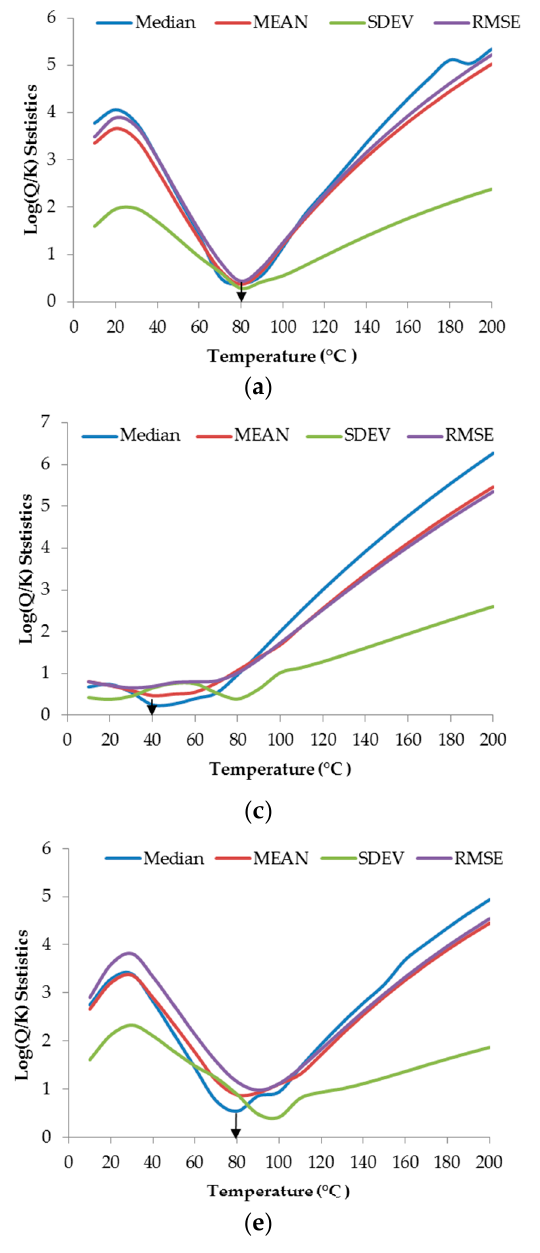
Figure 11. Statistical analyses of saturation indices: median, mean standard deviation (SDEV) and mean root square error (RMSE) of absolute log(Q/K) values as a function of model reservoir temperature (Group I higher temperature thermal CO 2 -rich water: Sample 8). The reservoir temperature is inferred from the temperature at which the value of the median is a minimum. Group I higher temperature thermal CO 2 -rich springs: ( a ) Sample 6; ( b ) Sample 12; Group II lower temperature thermal CO 2 -rich springs; ( c ) Sample 28; ( d ) Sample 2; ( e ) Sample 4; Group III shallow groundwater; ( f ) Sample 29.